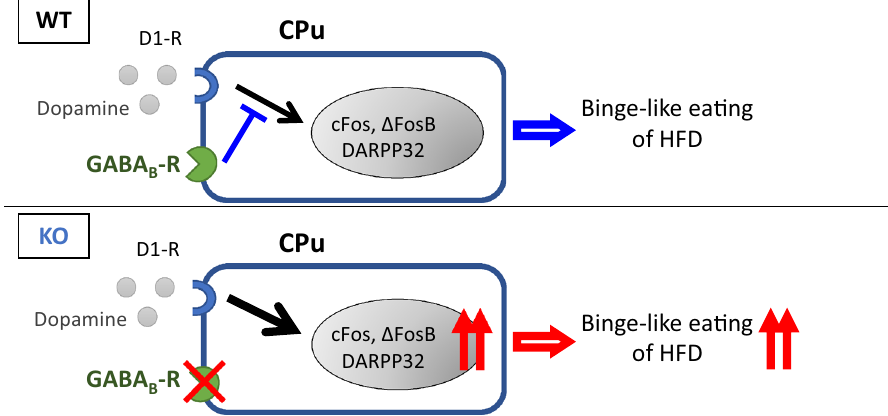
Figure 7. Schematic of role of GABA B R signaling in striatum in suppression of binge-like consumption of a HFD. We suggest that gamma-aminobutyric acid type B receptor (GABA B R) signaling in the caudate putamen (CPu) suppresses the binge-like consumption of a high fat diet (HFD) by inhibiting downstream of dopamine receptor d1 (drd1) signaling in the CPu. The figure image was drawn using PowerPoint 2017 (Microsoft,